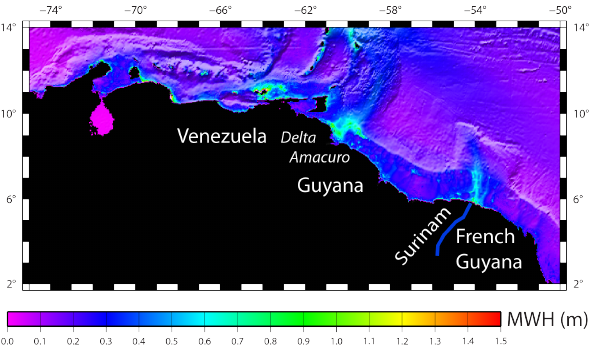
Figure 6. Maximum wave height maps after 12h of tsunami propa- gation for the 1843-like scenario (no. 2) showing coastal amplifica- tions in the south of the Lesser Antilles arc and along the northeast- ern margin of South